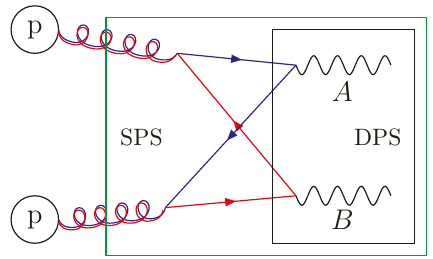
Figure 2 . Example of a process which can be seen either as a DPS or as an SPS. If the hard process is de(cid:12)ned by the black box, then it is a DPS with the two subprocesses q(cid:22)q the case where the hard process is de(cid:12)ned by the green box, then one has the SPS gg The pieces which are not included within the boxes are integrated out inside the